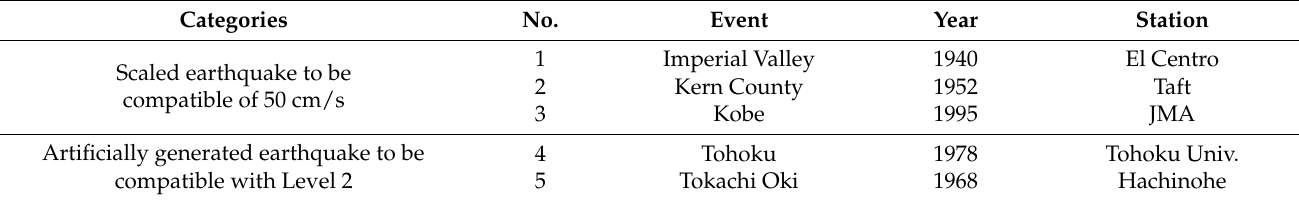
Table 3. List of selected earthquake ground